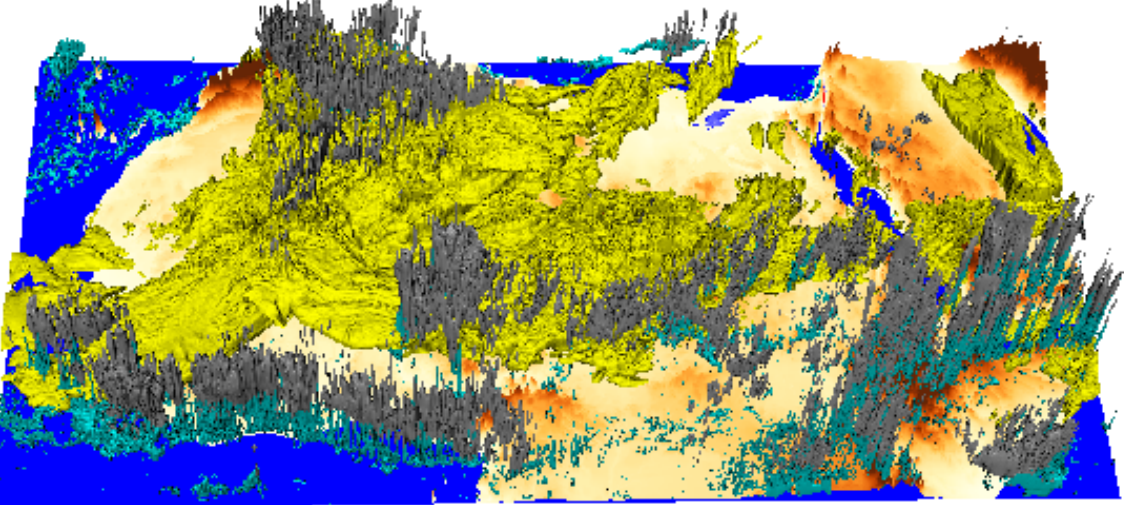
Figure 17. Cloud (grey), precipitation (blue), and dust (yellow) during a dusty outbreak at 12:00UTC on 12 June 2006 over the northern part of Africa as obtained by a simulation using a grid of 3072 × 1536 × 70 points and a grid mesh of (cid:49)x = 2 .